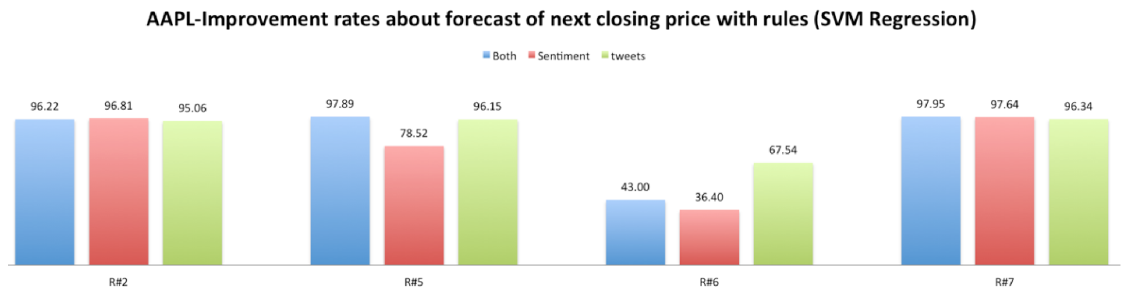
Figure 10. Improvement rates (expressed in %) of pattern intervals (rules) about AAPL by using SVM regression.